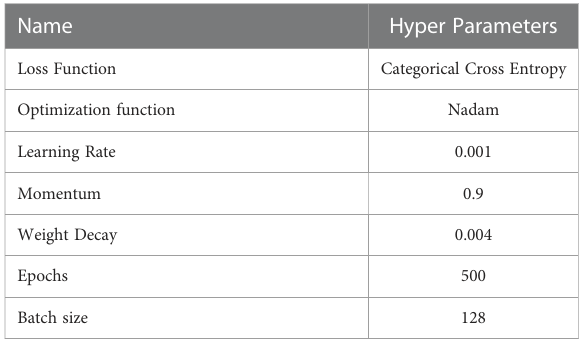
TABLE 4 Hyperparameters used during model training.